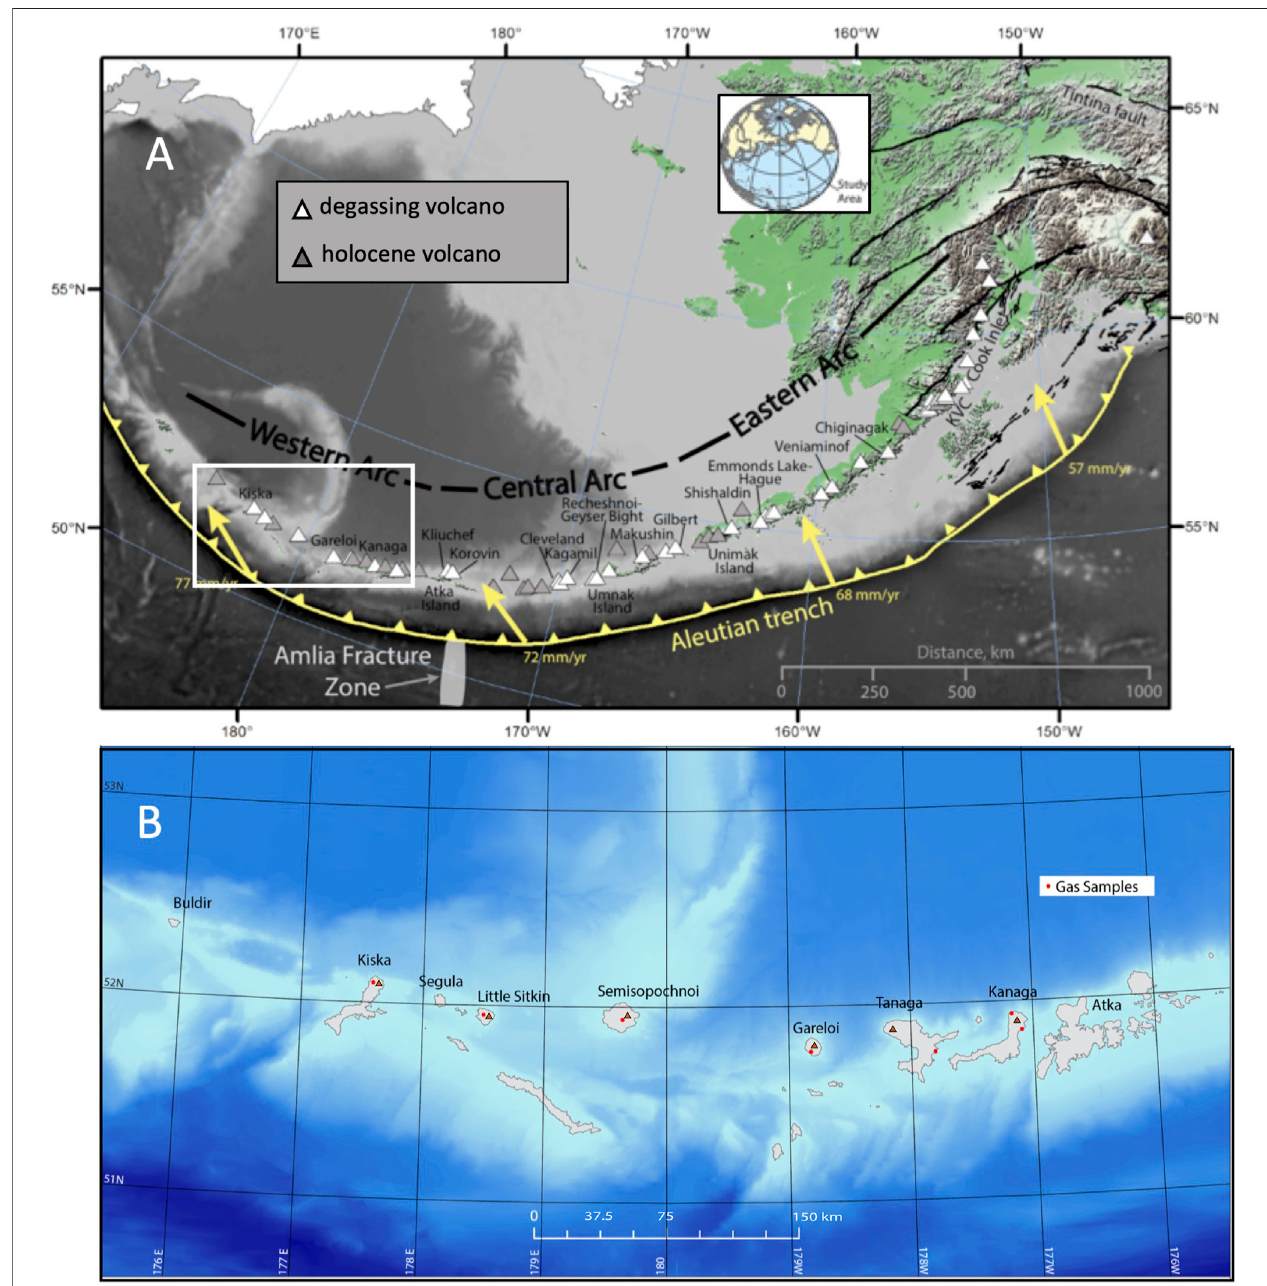
FIGURE 1 | (A) Map of the Aleutian Arc showing degassing volcanoes and volcanoes active in the Holocene. Note that the degassing volcanoes are also active in the Holocene. (B) shows the locations that were sampled for this study. Map provided by Dan Cole, Smithsonian Institution.